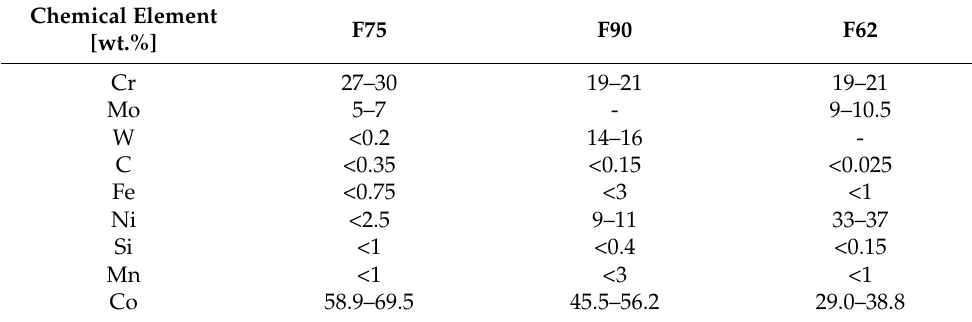
Table 7. Chemical composition of biomedical cobalt